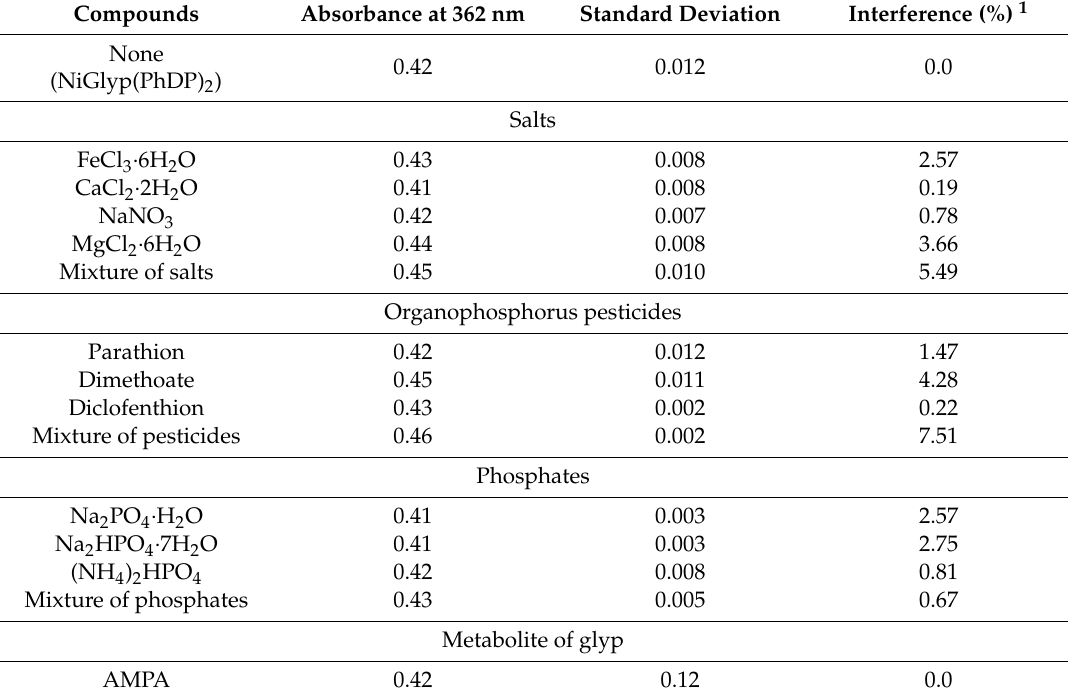
E ff ects of the added salts, organophosphorus pesticides, and phosphates on the method